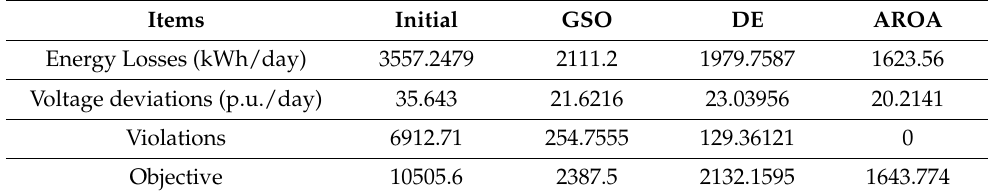
Table 4. Corresponding energy losses, voltage deviations, and violations for the third scenario for the IEEE 33-distribution system.